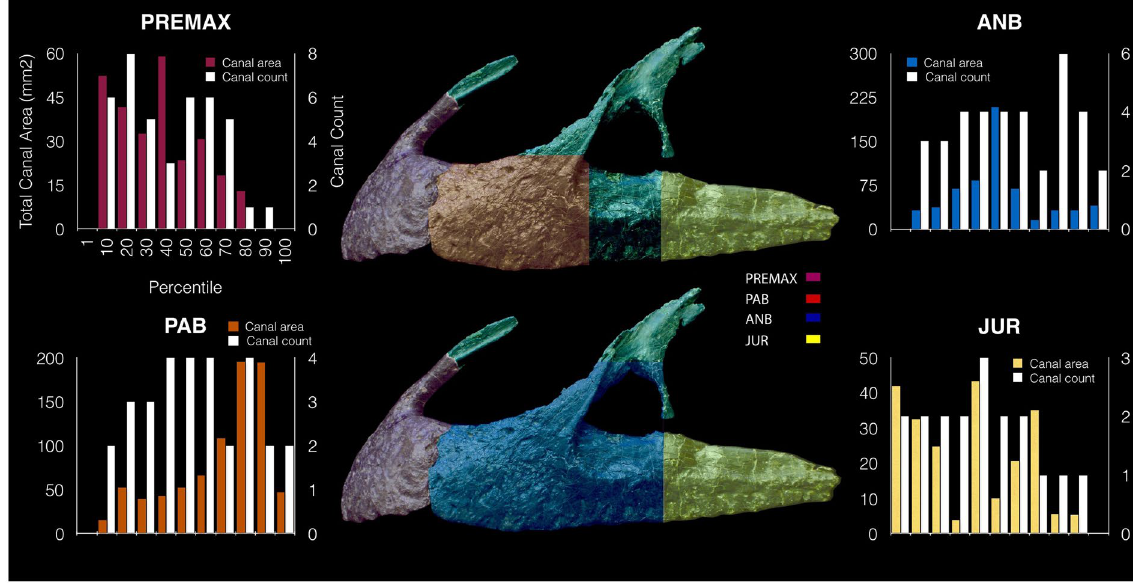
Figure 4. Lateral view of left premaxilla and maxilla, denoting maxillary anatomy as suggested by Hendrickx and Mateus 56 . Graphs denote changes in canal area versus canal count (i.e. number of observable canals per slice) at various regions of premaxillary and maxillary anatomy, based on data from Supplementary Table S1. Abbreviations: premax : premaxilla; pab : preantorbital body; anb : anterior body; jur : jugal